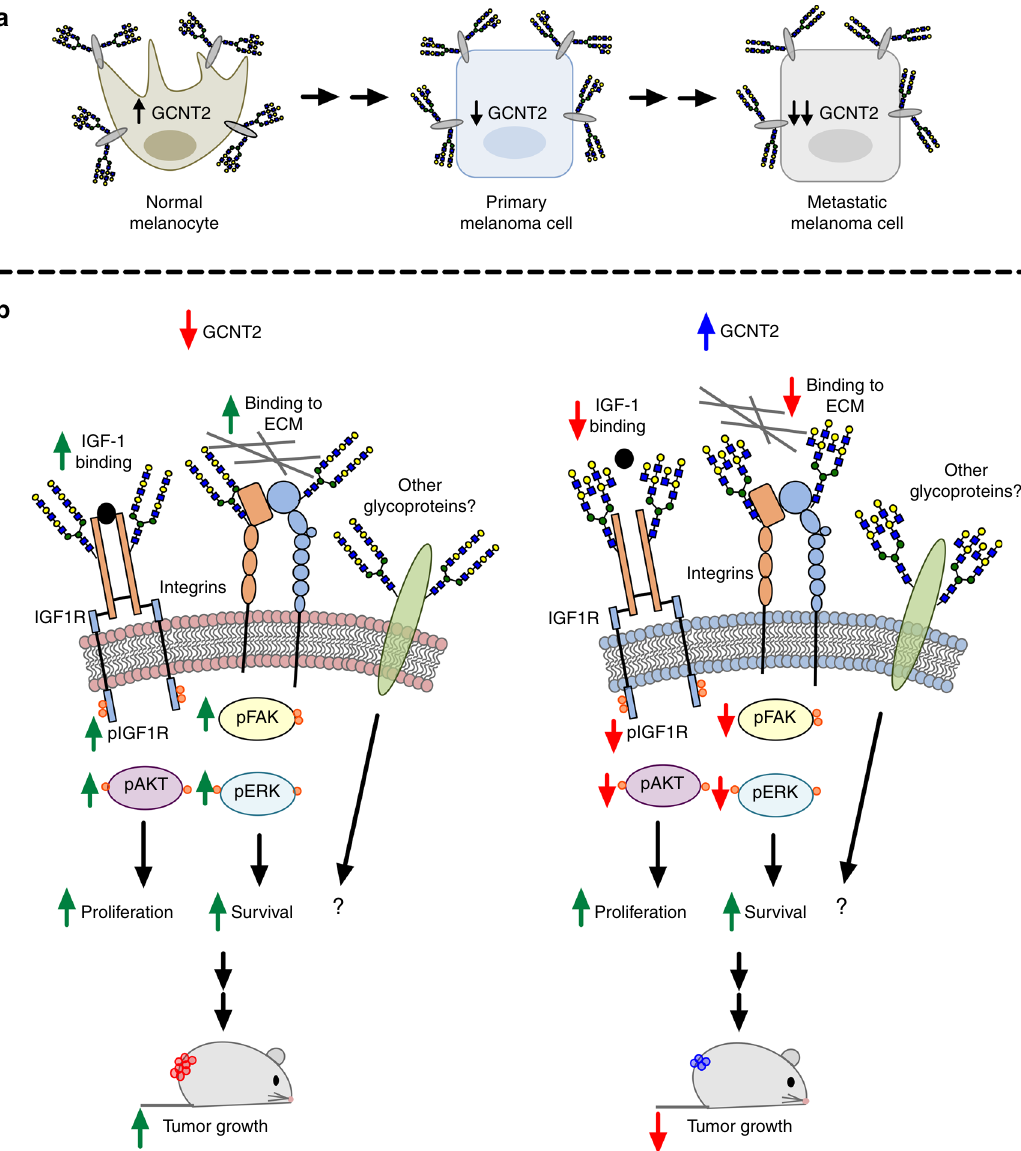
Fig. 8 GCNT2 negatively regulates melanoma cell growth and survival. a Melanomas downregulate the I-branching glycosyltransferase, GCNT2, upon malignant transformation, leading to the formation of extended poly-N-acetyllactosamine (i-linear) glycans on cell-surface glycoproteins. b Loss of GCNT2/I-branched glycans promotes melanoma growth and survival and enhances growth factor receptor and integrin-mediated cell proliferation and survival signaling